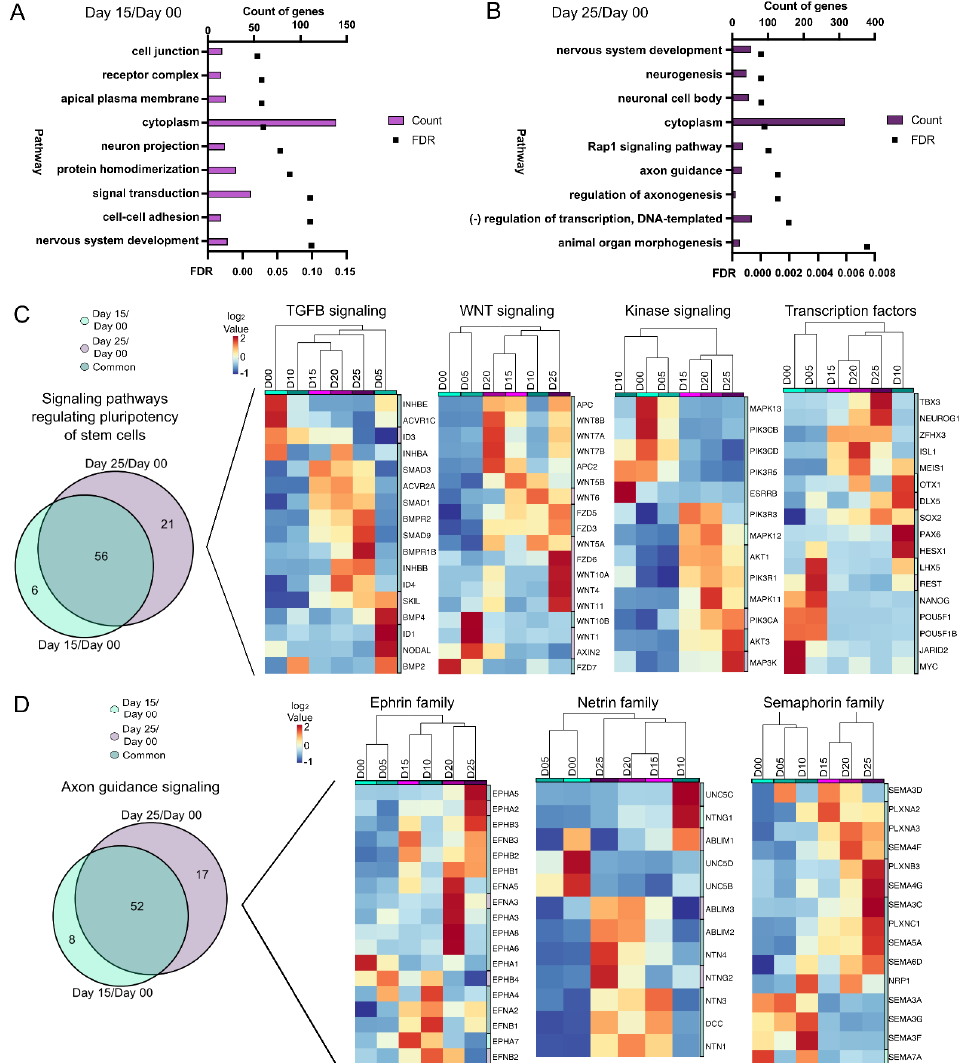
Figure 3. Pathway analysis of gene expression differences from PSCs through early retinal differentiation. ( A , B ) Pathway analysis showing the number of DEG/DARs and the FDR for the 9 statistically significant pathways between day 15/day 00 ( A ) and for 9 of the most significant pathways between day 25/day 00 ( B ) (FDR < 0.1). Bar graphs represent the number of DEG/DARs while line graphs represent the FDR. Further analysis was then done using only the DEGs ( C , D ). ( C ) “Signaling pathways regulating pluripotency of stem cells” was one common pathway between day 15/day 00 and day 25/day 00 based upon DEG expression. A Venn diagram of the DEGs detected in “Signaling pathways regulating pluripotency of stem cells” at day 25/day 00 and day 15/day 00 time points identified 6 genes unique to day 15/day 00, 21 unique genes in day 25/day 00, and 56 genes com- mon between the comparisons (( C ), left ). The DEGs were further classified into hierarchical cluster analyses of days 00 through 25 of TGF β signaling, Wnt signaling, kinase signaling, and transcription factors and heatmaps of these genes were generated (( C ), right ). ( D ) “Axon guidance” was also a pathway in common between day 15/day 00 and day 25/day 00 based on DEGs. A Venn diagram of the DEGs identified in “Axon guidance” at the day 25/day 00 and day 15/day 00 time points identified 8 unique DEGs in day 15/day 00, 17 unique DEGs in day 25/day 00, and 52 DEGs in common between the comparisons (( D ), left ). DEGs involved in “Axon guidance” were further categorized into hierarchical cluster analyses of ephrin, netrin, and semaphorin families of genes and heatmaps of these genes were generated (( D ), right